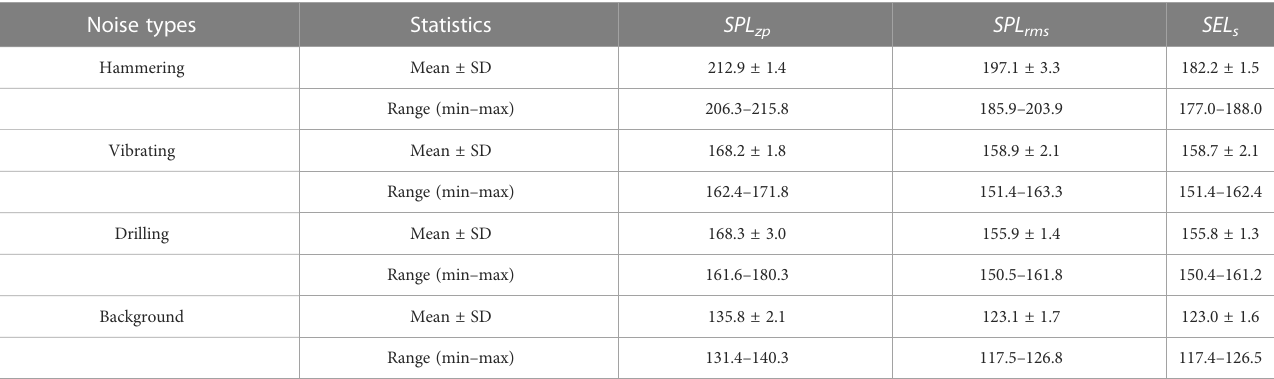
TABLE 1 Source levels of hammering noise, vibrating noise, and drilling noise during OED.